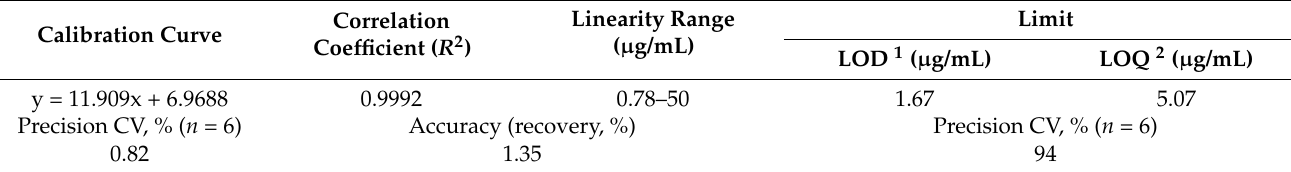
Table 1. Calibration parameters of the method for vitamin D 2 detection and quantification, and method validation parameters using Agaricus bisporus Portobello irradiated with UV-C (6 min, 3200 mJ/cm 2 ). Calibration